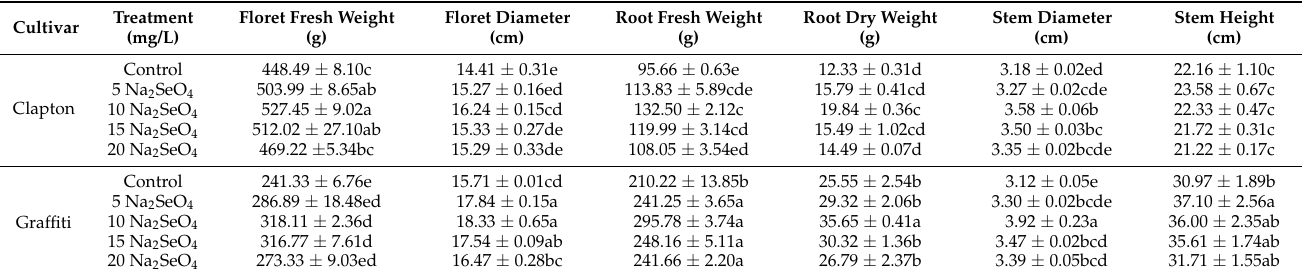
Table 1. Mean comparison of sodium selenate (Na 2 SeO 4 ) on growth characters of cauliflower cultivars “Clapton” (white) and “Graffiti” (purple). In each column different letters indicate significant differences at the 1% and 5% level based on Duncan’s multiple range tests with three replications.